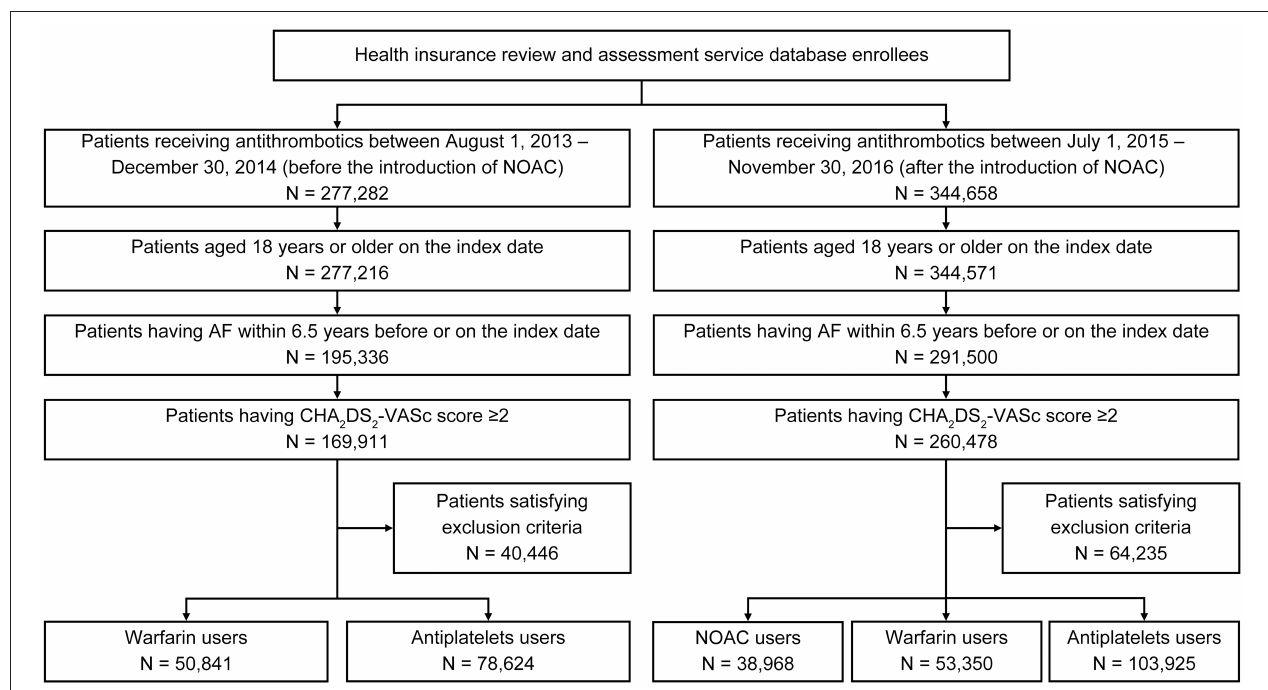
FIGURE 1 | Patient selection flow diagram. AF, atrial fibrillation; NOAC, non-vitamin K antagonist oral anticoagulants.